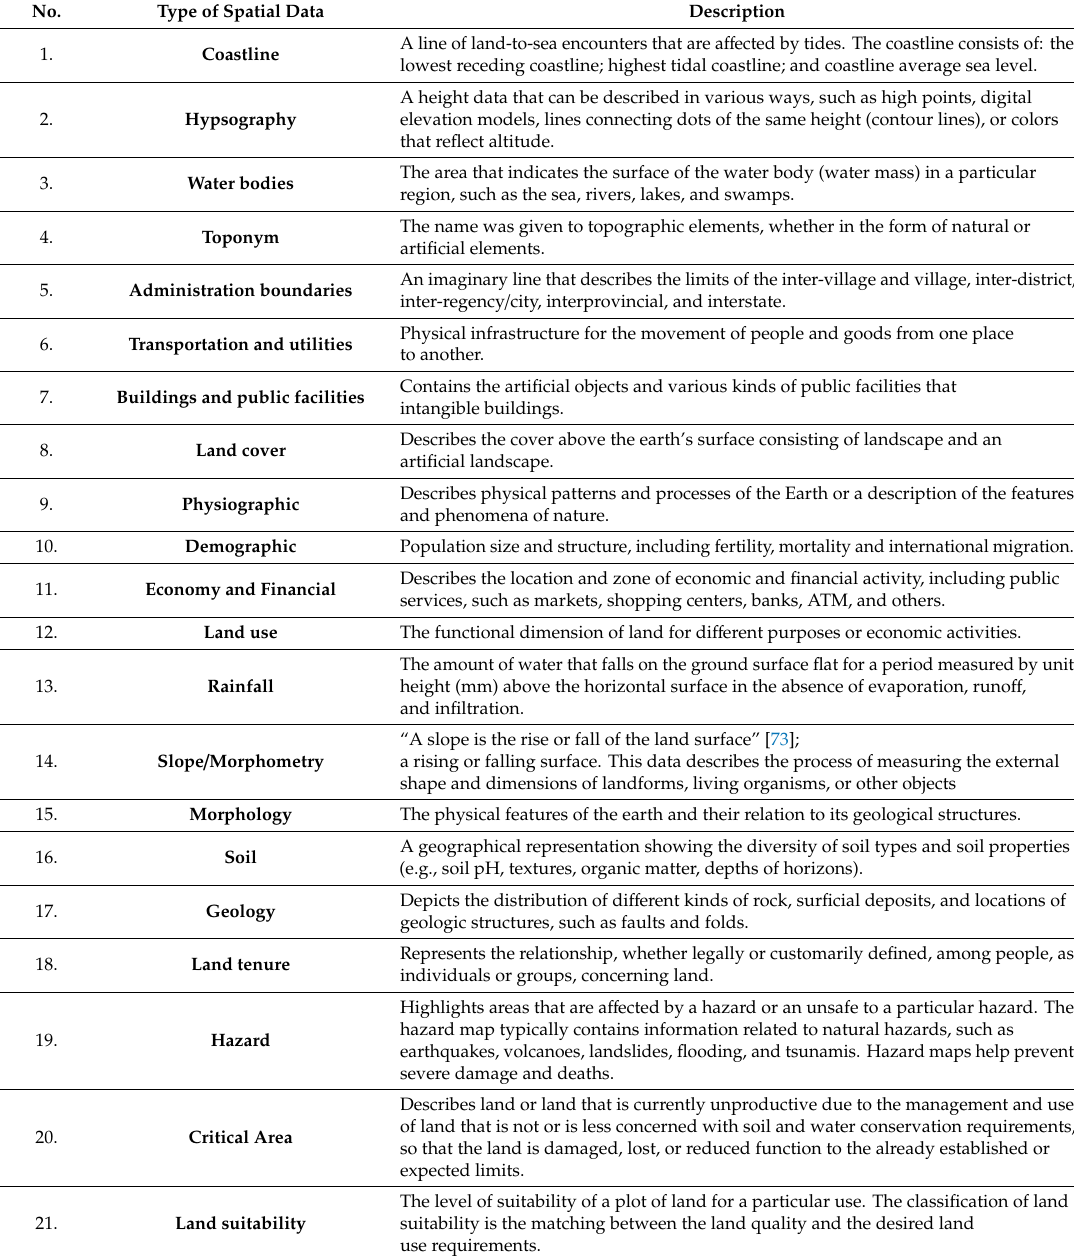
Table A1. List of spatial information required urban planning process at map scale 1:5000 or better (Ministry of Public Works Regulation, 2011) which are produced by government